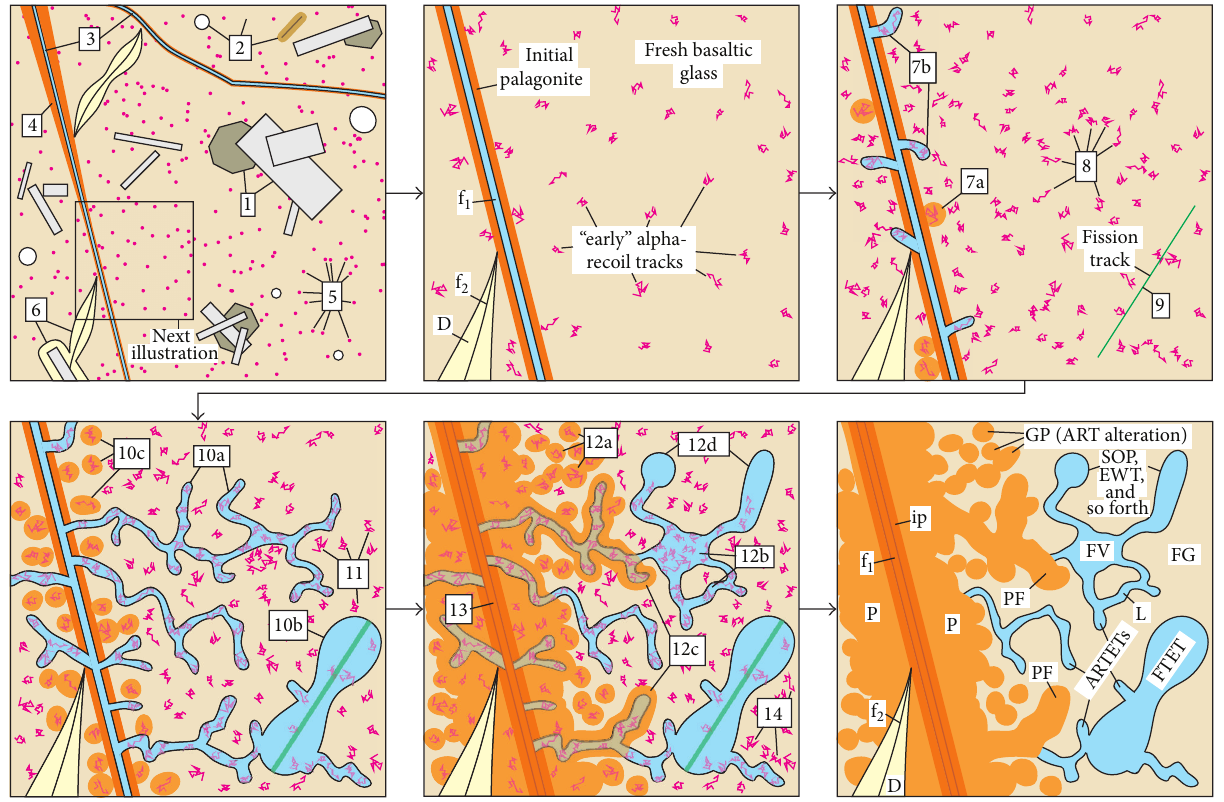
Figure 18: Schematic illustrations depicting the abiotic, stepwise development of complex petrographic microtextures in DSDP 418A basaltic glass (with emphasis on the corrosion of radiation damage). The final illustration (at lower right) highlights the key dissolu- tion/palagonitization microtexturesin DSDP418Abasalticglassthat arereadily observablebytransmittedlight microscopy andSEM.